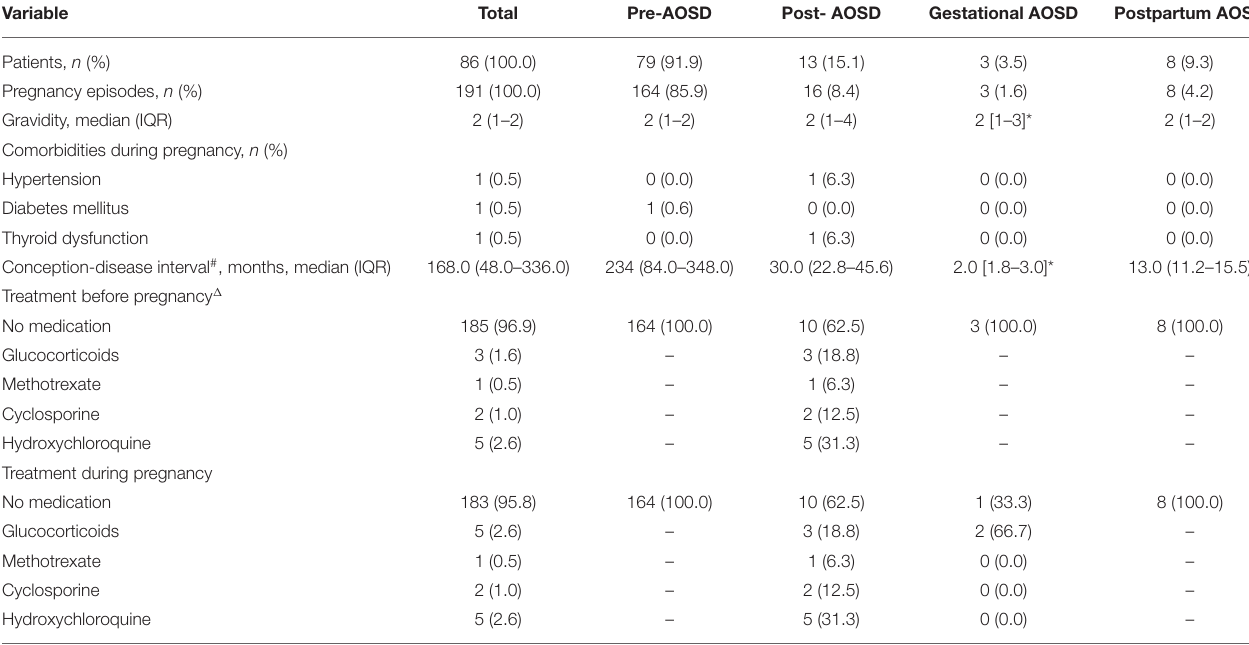
TABLE 1 | Characteristics of 191 pregnancies grouped by temporal relationship between disease onset and pregnancy. Variable Total Pre-AOSD Post- AOSD Gestational AOSD Patients, n (%)